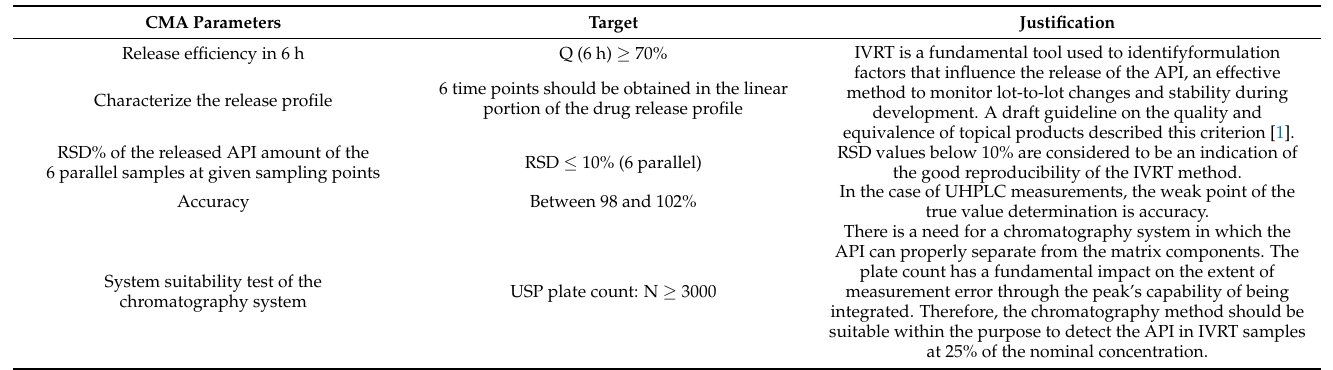
Table 3. Critical method attributes of diclofenac sodium topical